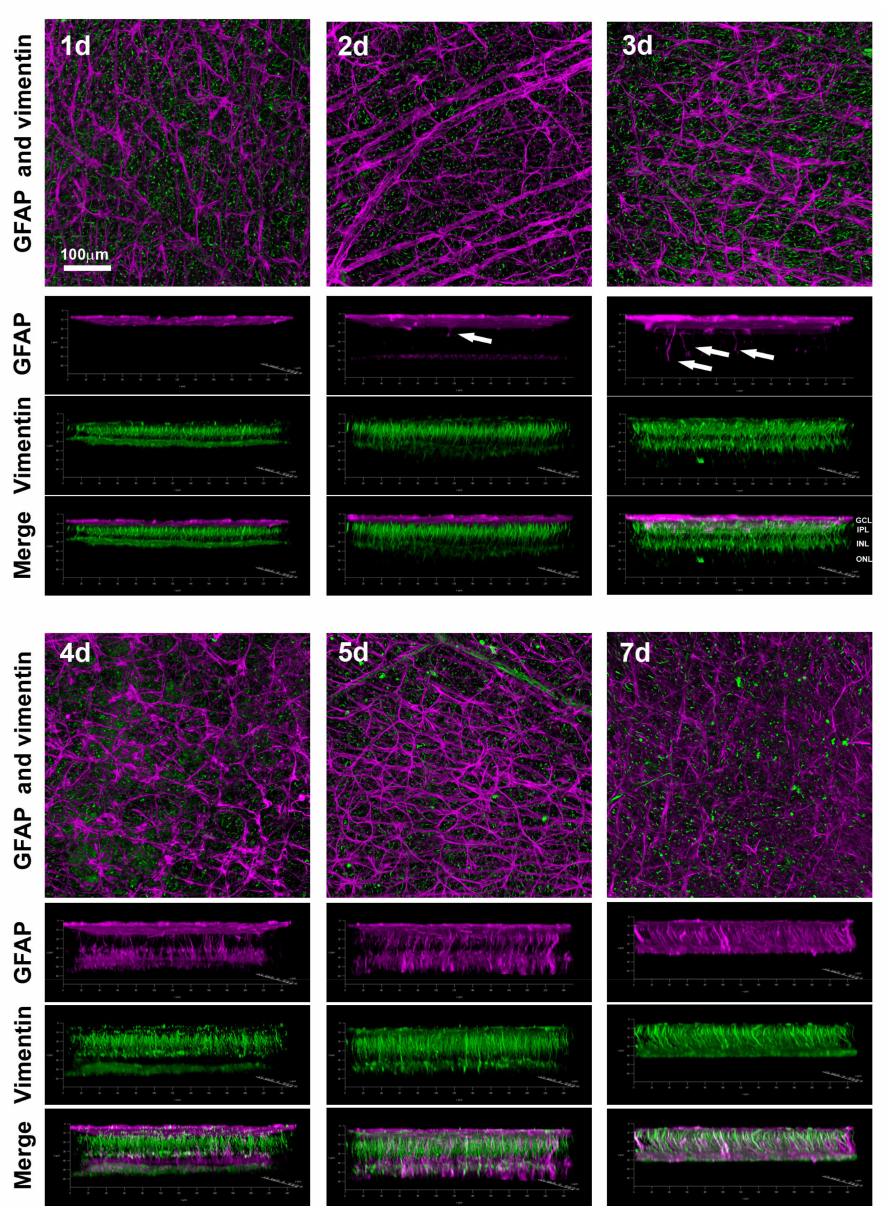
Figure 6. Early induction of macrogliosis in ROCs. Representative confocal microphotographs focused on the ganglion cell layer of ROCs immunodetected against GFAP (purple) and vimentin (green). Below each image, the 3D representations of the full thickness of each ROC are shown. Arrows point to reactive Müller cells. GCL: ganglion cell layer. IPL: inner plexiform layer. INL: inner nuclear layer. ONL: outer nuclear layer. n = 4–6 retinas/group/time